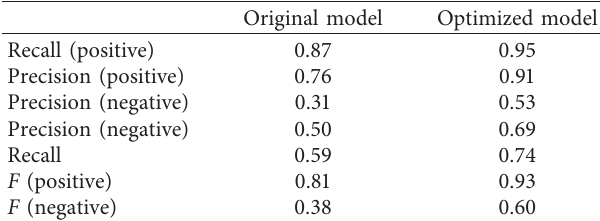
Table 5: Comparison of evaluation indexes.